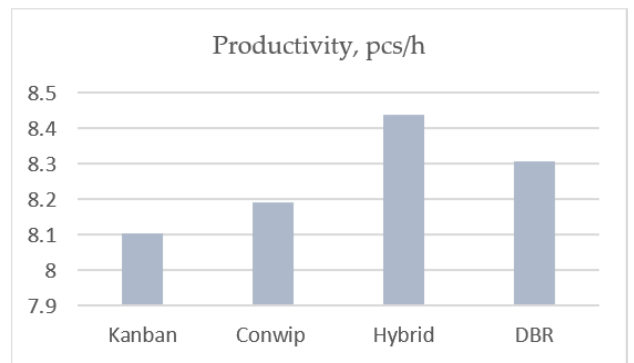
Figure 3. Comparison of the effectiveness of pull control mechanisms in the process with bottleneck for Cv = 1.25, t = 5min, WIP = 5.